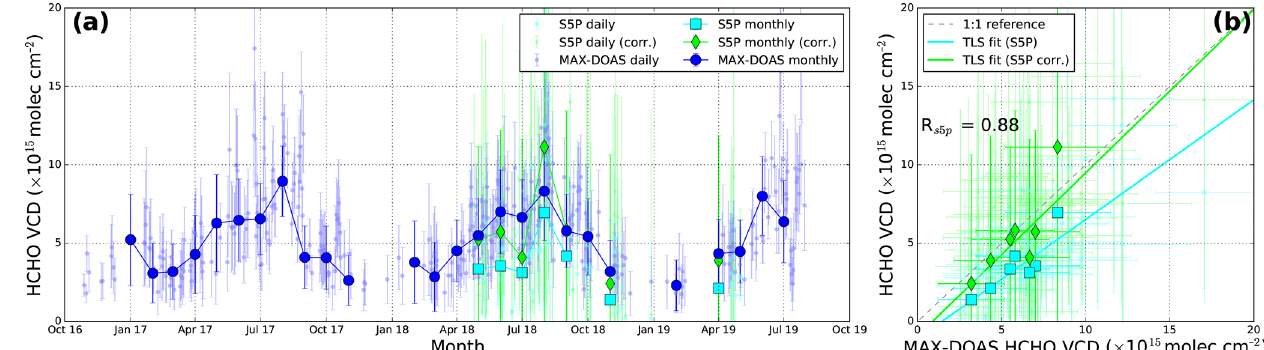
Figure 12. (a) Time series of tropospheric HCHO vertical column densities measured by MAX-DOAS and TROPOMI. MAX-DOAS data are temporally averaged around the TROPOMI overpass time, while TROPOMI observations are spatially averaged within 10km of the MAX-DOAS measurement site. TROPOMI VCDs retrieved using MAX-DOAS profile as a priori information are also indicated (labeled